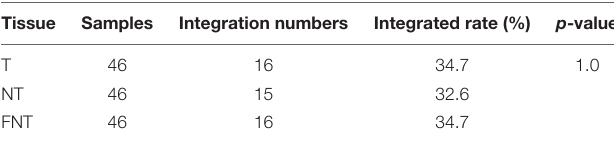
was higher only in NT than FNT samples ( p = 0.02) ( Figure 4A